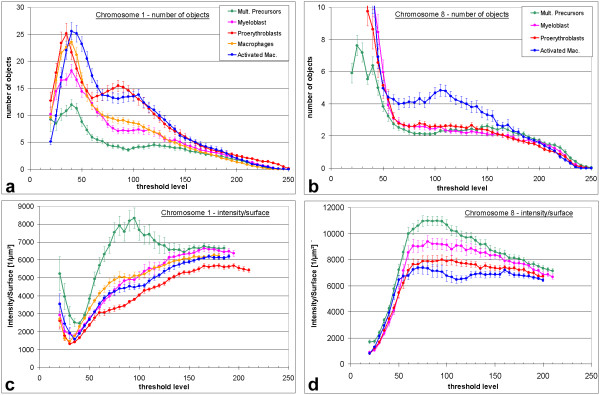
Disaggregation of chromosome territories in objects. (a,b) mean number of objects at increasing thresholds for chicken chromosome 1 (a) and chromosome 8 (b) territories. When the starting threshold of 20 is gradually increased, the nuclear background produces at first few and then many objects (around threshold 40). Suppression of nuclear background occurs at thresholds between 60–70, leaving chromosome territories only. The range above these thresholds is thus the most interesting since it is here where the territories start to break up in several objects (compare Fig. 2). These objects are gradually lost at further increasing thresholds. Values for macrophages are not directly comparable to other cell types since they contain additional chromosomes (see Methods). (c, d) Chromatin content per surface. Signal intensity of objects was divided by object surface area and averaged (see Methods for details). Since additional chromosomal parts add intensity as well as surface, this parameter is unsusceptible to aneuploidy.